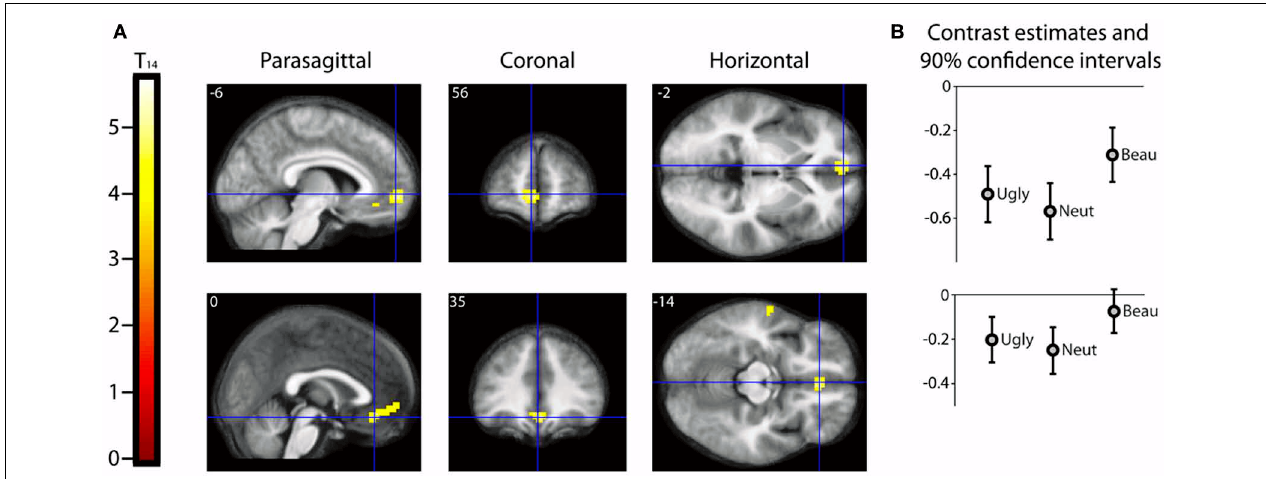
FIGURE 3 | Parametric “Activations” with Beauty. (A) Second level parametric analysis derived from 15 subjects, to show parametric modulation by scan-time beauty rating (after orthogonalization to understanding rating). One-sample t -test ( df = 14) thresholded at P unc < 0 . 001 with an extent threshold of 10 voxels, revealed a cluster of 95 voxels in medial orbito-frontal cortex (mOFC) with hot-spots at ( − 6, 56, − 2) and (0, 35, − 14), significant at cluster level, with familywise error correction over the whole brain volume. The location and extent of the cluster is indicated by sections along the three principal axes through the